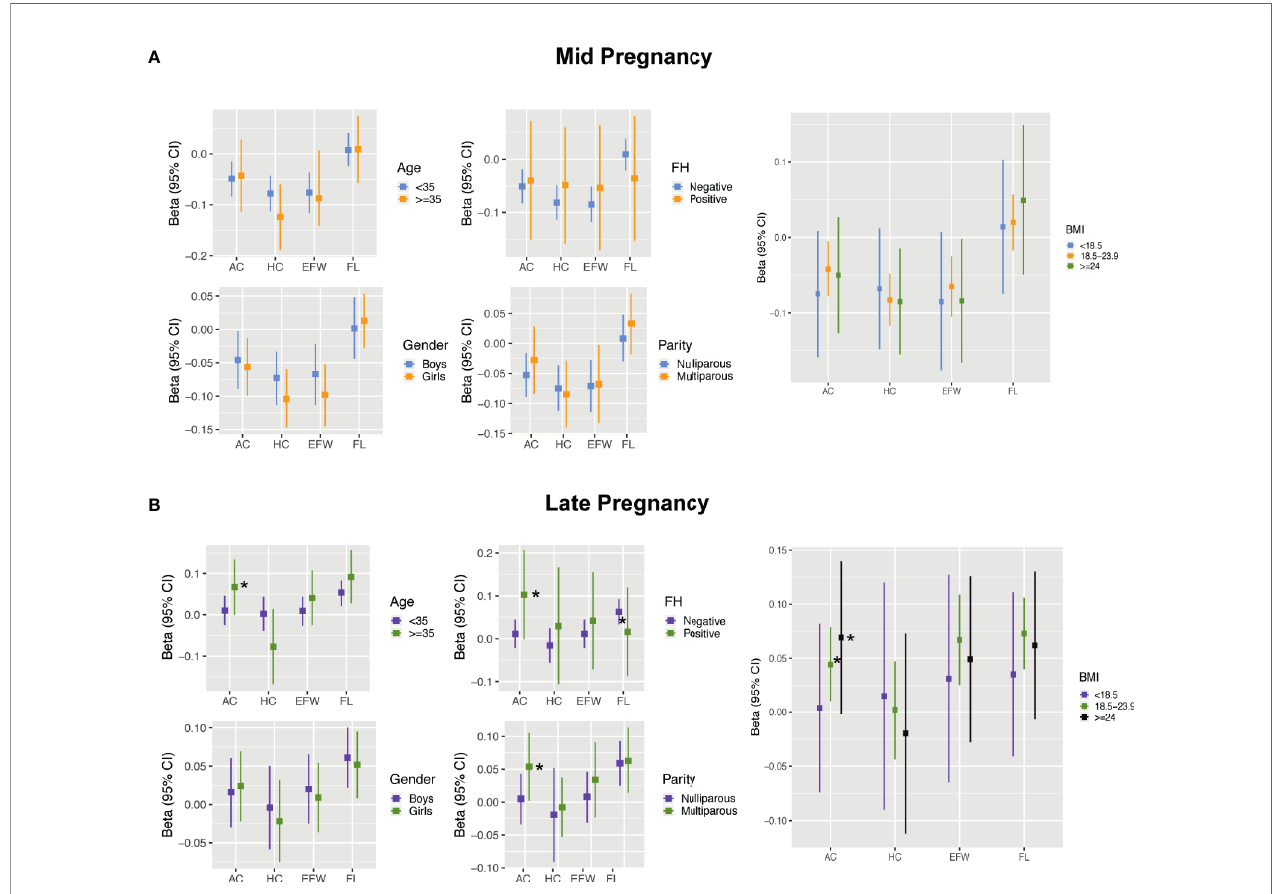
FIGURE 4 | Results for effect modi fi cation by maternal and fetal characteristics in mid pregnancy (A) and late pregnancy (B) . Covariates of adjustment in models: maternal age, parity, pre-pregnancy BMI, gestational age of sample collection, family history of diabetes, and fetal gender. AC, abdominal circumference; HC, head circumference; EFW, estimated fetal weight; FL, femur length; FH, family history of diabetes; BMI, body mass index. *Represent signi fi cant association after full adjustment in subgroups for